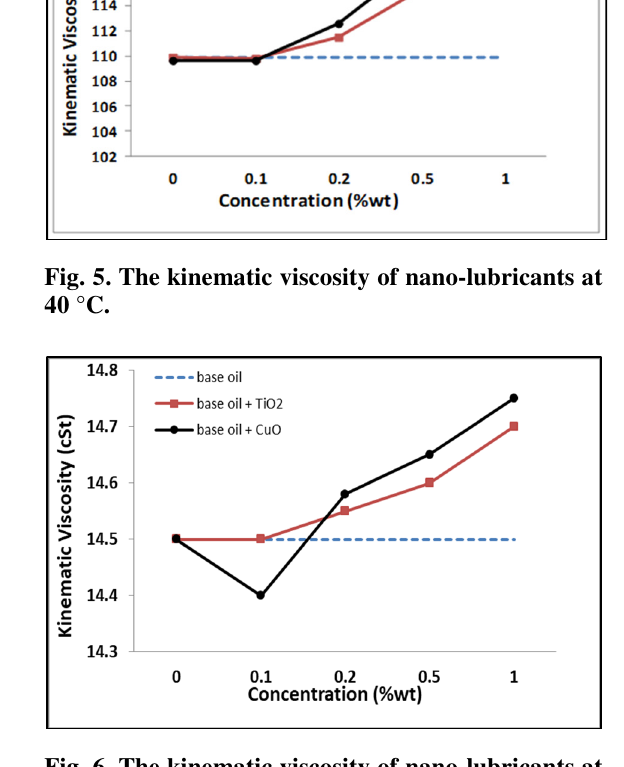
Fig. 6. The kinematic viscosity of nano-lubricants at 100